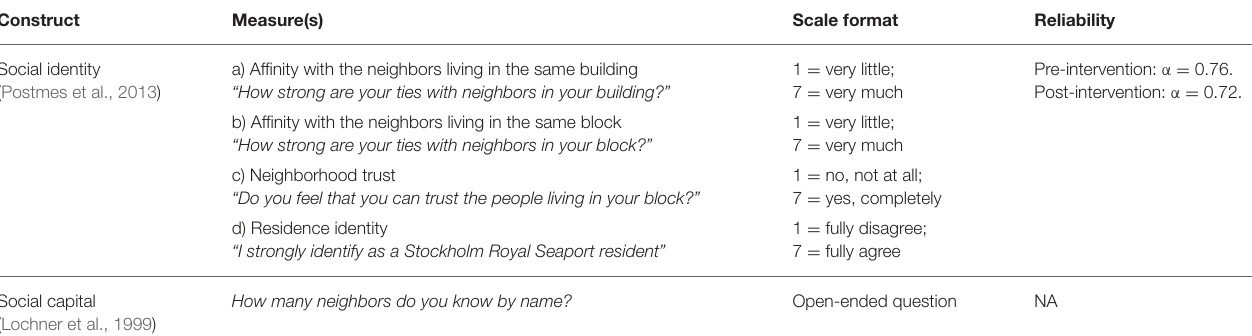
TABLE 2 | Overview of measures, scale formats, and reliability estimates.